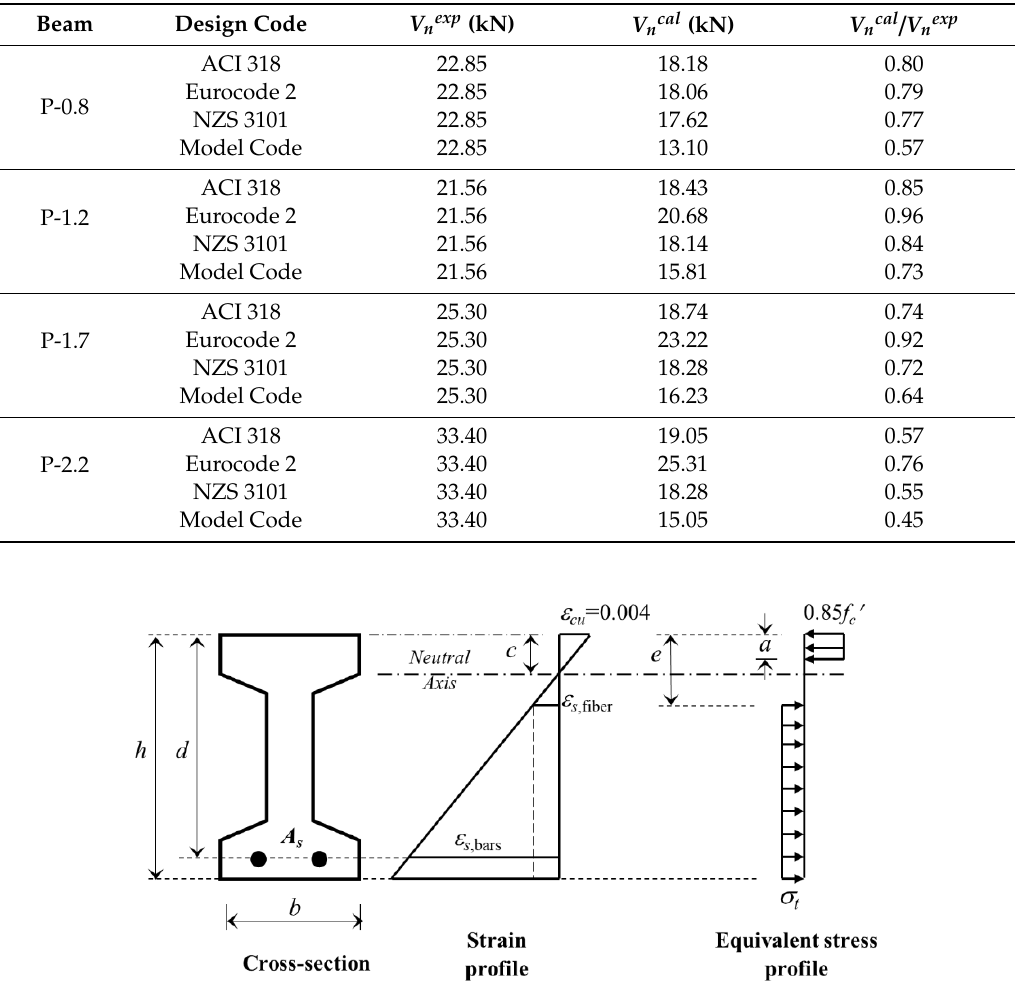
Table 5. Nominal shear strengths of ultra-high performance concrete (UHPC) beams.